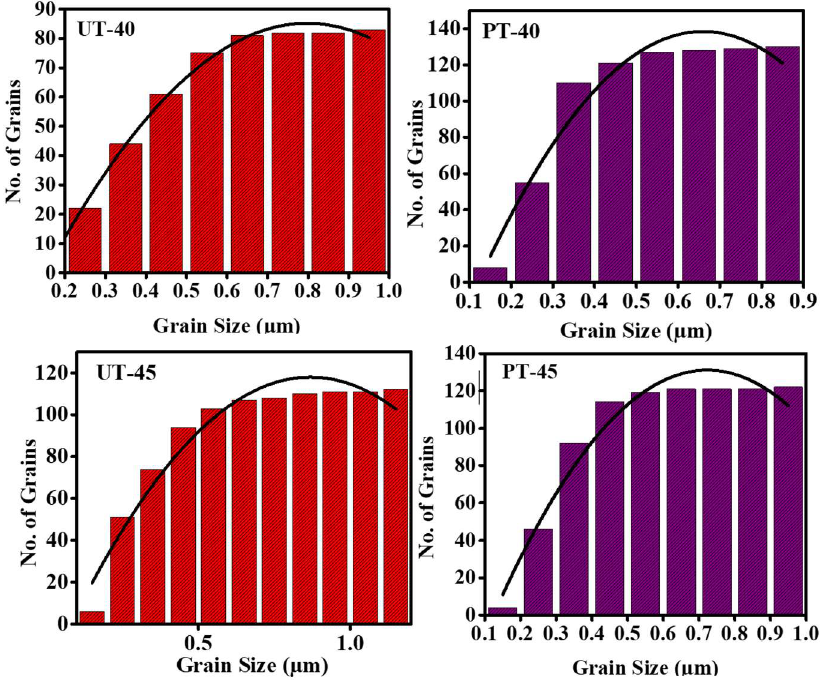
Figure 5. A statistical representation of grain distribution for pristine and plasma − treated ferrite.